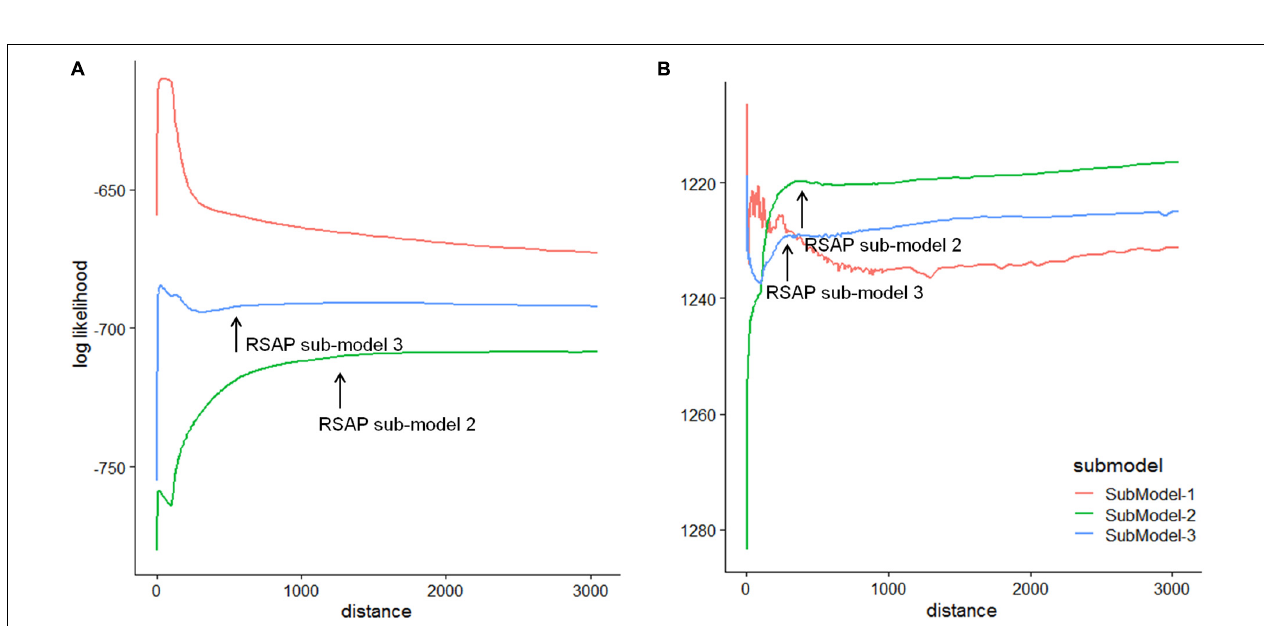
Frontiers in Ecology and Evolution |